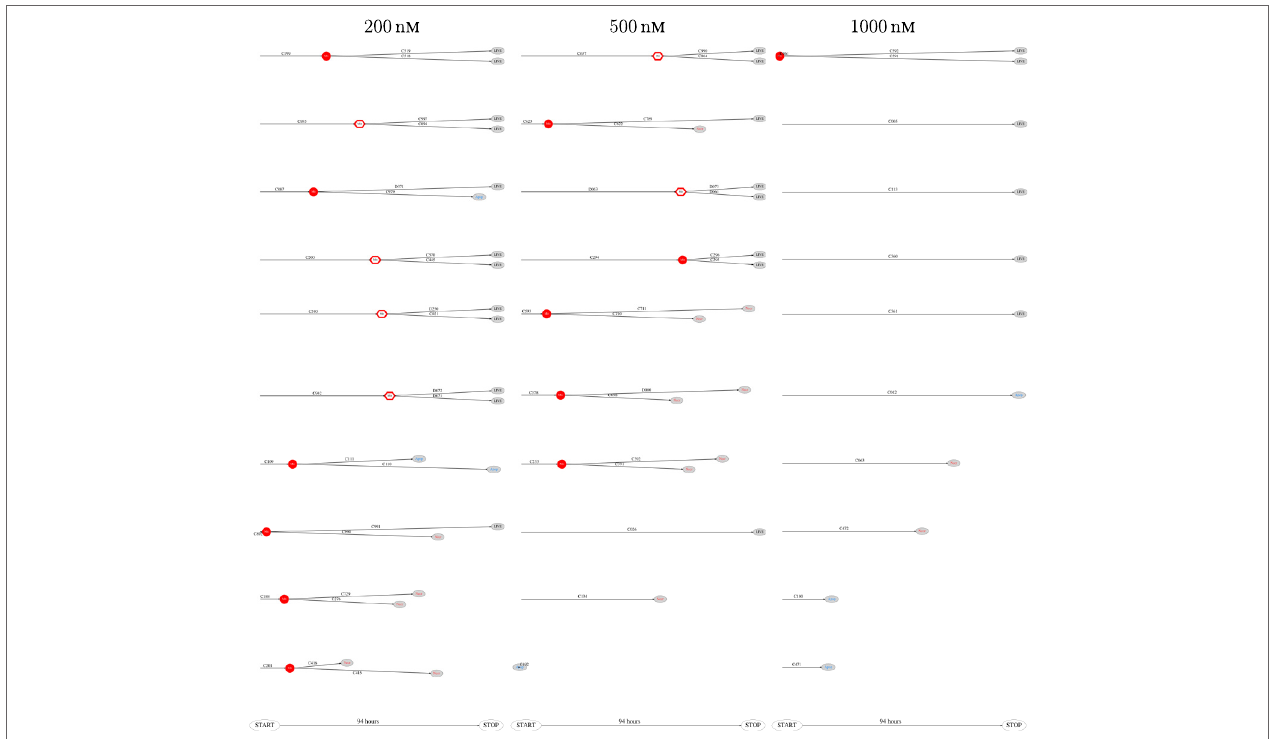
FigUre 8 | The 10 smallest pedigree trees for cells exposed to YTX at concentrations 200, 500, and 1,000 nM (respectively from left to